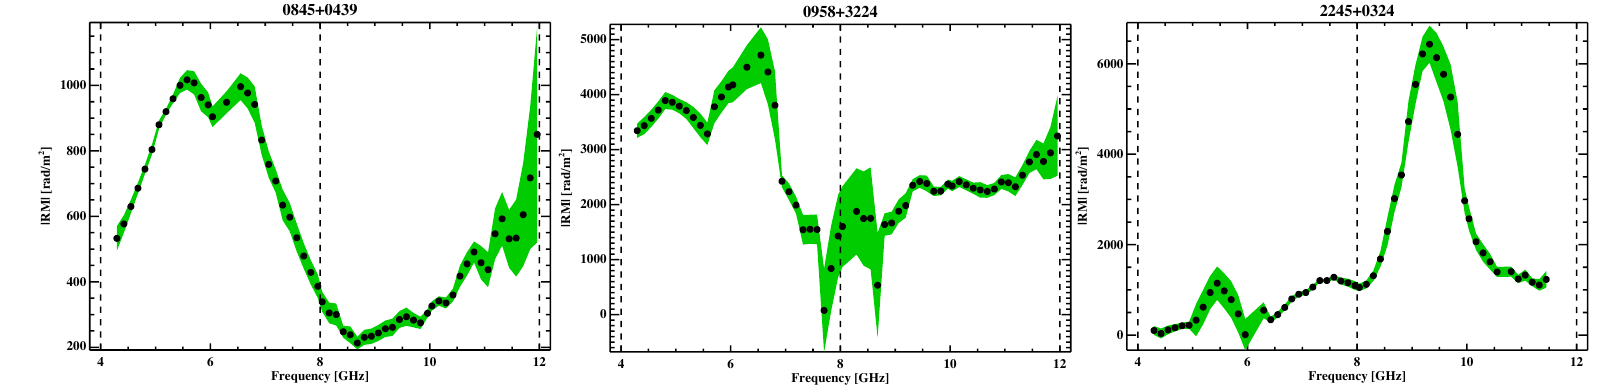
Figure 3. Rotation measure (RM) with frequency behaviour at C and X bands.